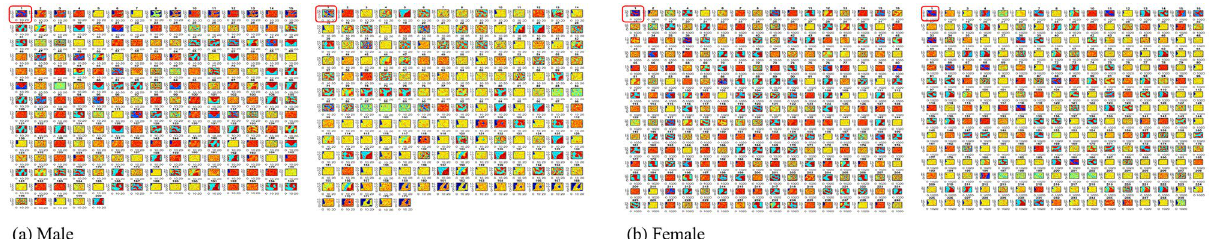
Figure 4. SOM component planes visualization for African isolates. Component planes 1 (encircled) represent the SARS-CoV-2 reference genome. The male and female isolates have 2 SOM maps each with country and (component plane map position(s)) distributed as follows: Male—( a ) Map 1: Cameroon (2), Ghana (3–15), South Africa (16–200). Map 2: South Africa (2–63), Gambia (64–66), Algeria (67), Egypt (68–81), Tunisia (82–90), Morocco (91–92), Mozambique (93–96), Nigeria (97–107), Senegal (108–156), Rwanda (157–173). Female—( b ) Map 1: Ghana (2), South Africa (3–240). Map 2: South Africa (2–186), Gambia (187), Algeria (188), Egypt (189–194), Tunisia (195–203), Madagascar (204), Nigeria (205–208), Senegal (209–237), Rwanda (238–239).